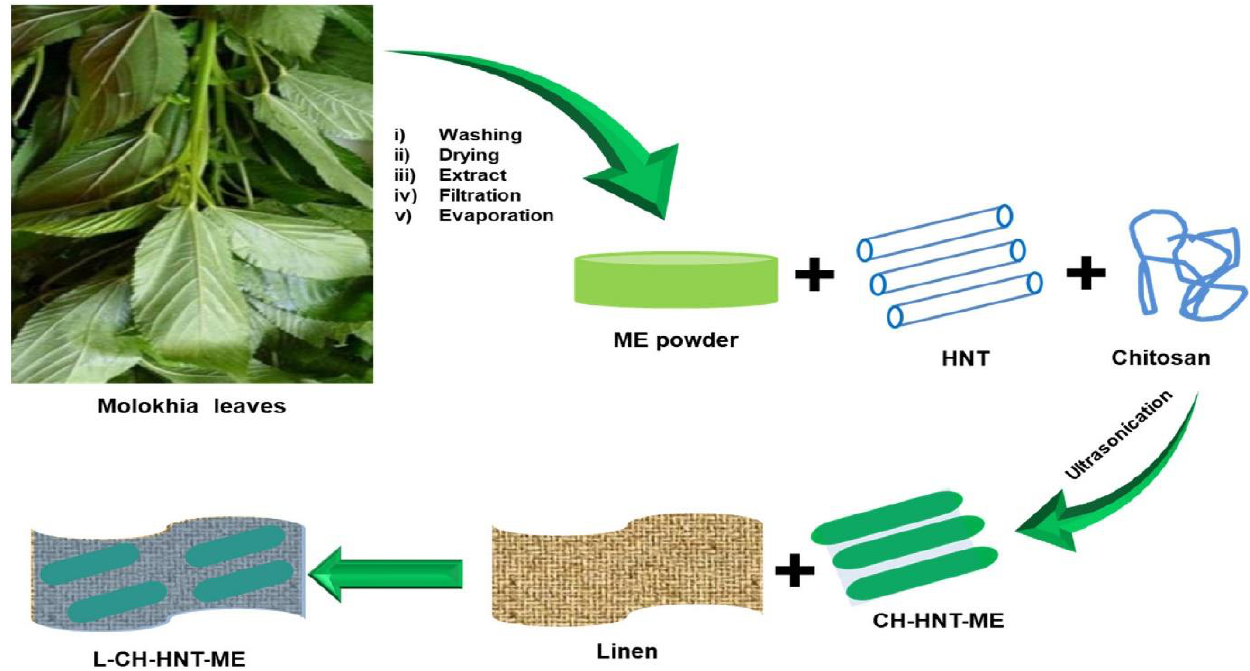
Figure 1. Schematic diagram representing the synthesis of green textile coatings CH-HNT-ME and their linen textile fabrics composite L-CH-HNT-ME, reproduced with permission [9]. Copyright 2022, Elsevier.